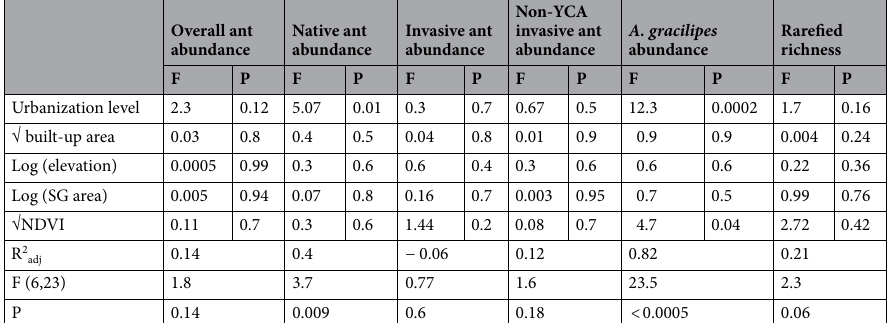
Table 2. Parameter estimates from the linear models analyzing the responses of ant variables to landscape and local variables.